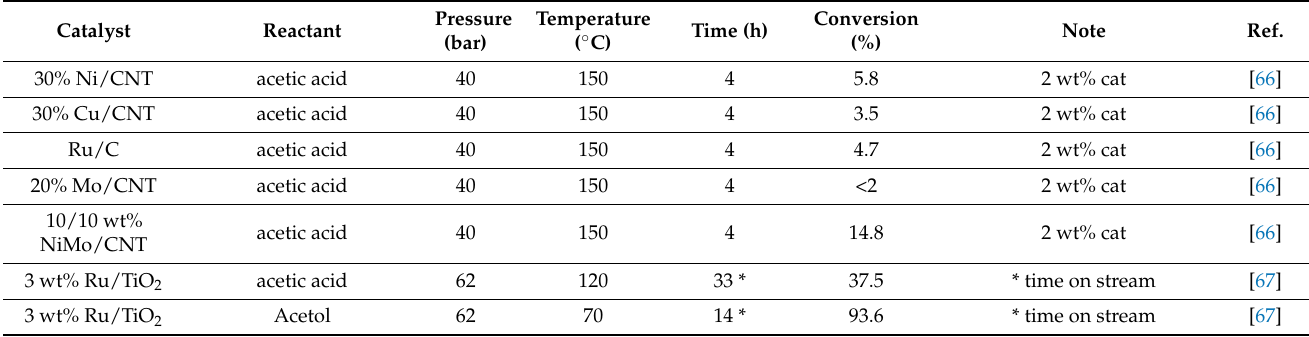
Table 3. Hydrogenation